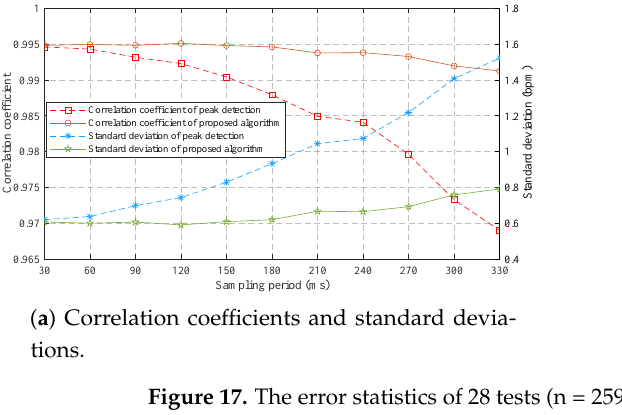
Figure 17. The error statistics of 28 tests (n = 2592) measured at different sampling periods.